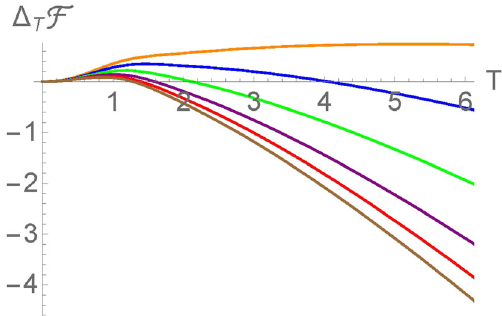
Fig. 10 Free energy, (cid:8) T F ,(23), forthe ’sine-Gordon’ combas afunc- tionof T for: (cid:5) = 0 . 1(orangeline), (cid:5) = 0 . 25(blueline), (cid:5) = 0 . 5(green line), (cid:5) = 0 . 75 (purple line), (cid:5) = 0 . 9 (red line) and (cid:5) = 1 (brown line). We have chosen for the lattice spacing a =